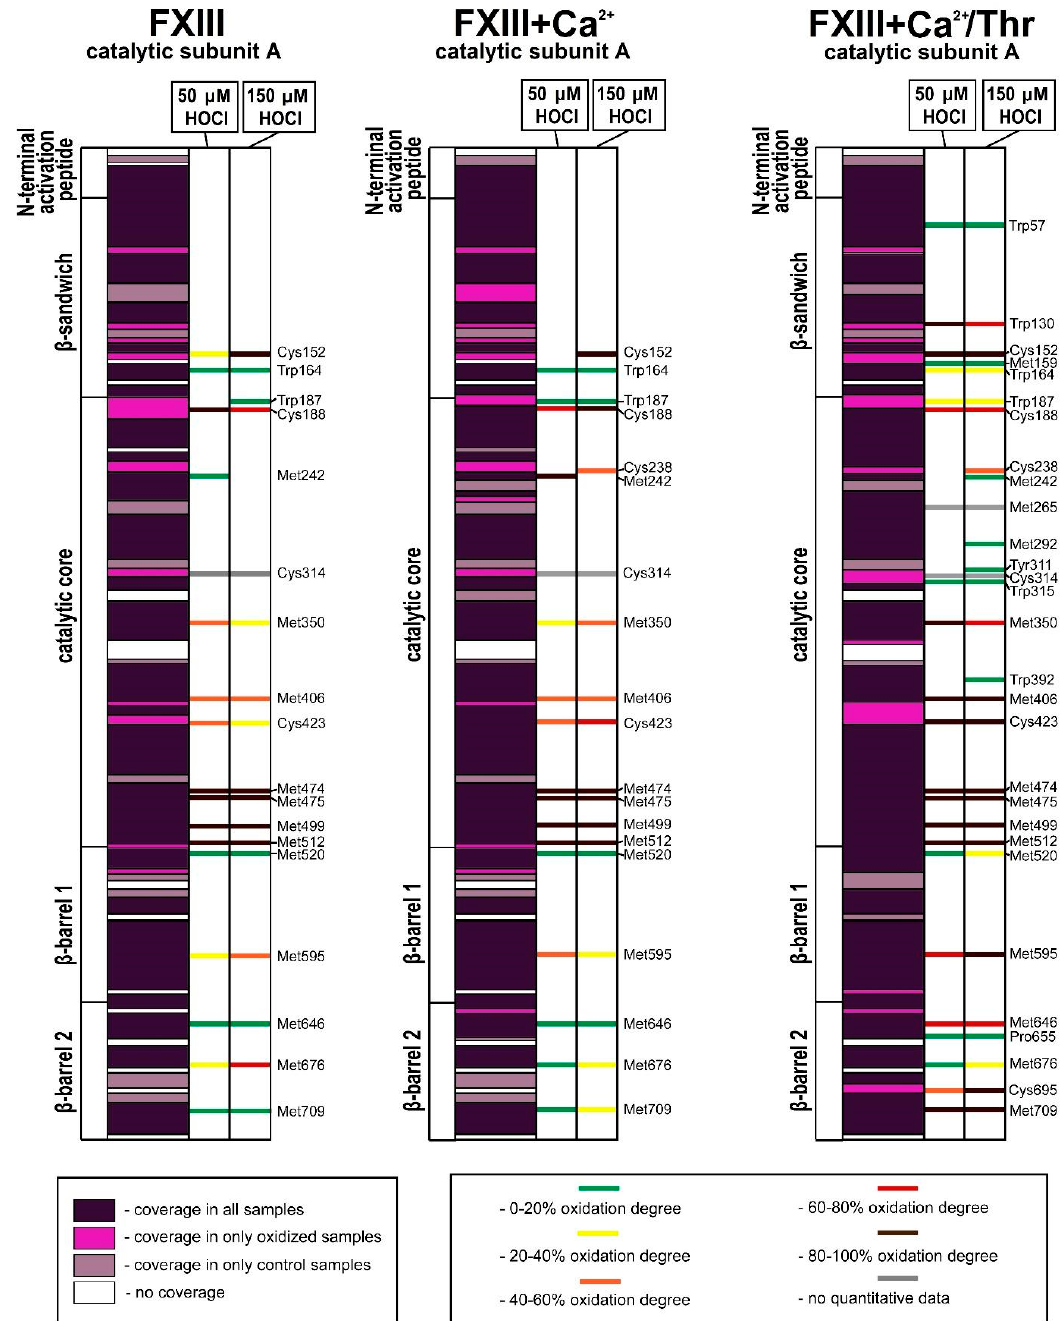
Figure 5. Sequence coverage (left columns) and oxidative modifications in the catalytic FXIII-A subunit of the various FXIII samples subjected to 50 μ M (middle columns) and 150 μ M hypochlorite (right columns). FXIII, FXIII + Ca 2+ , and FXIII + Ca 2+ /Thr are the samples of the catalytic FXIII-A subunit in the non-activated FXIII, the FXIII activated only by Ca 2+ , and the FXIII activated by the combined action of Ca 2+ and thrombin, respectively. The label color depends on the overall oxidation degree.